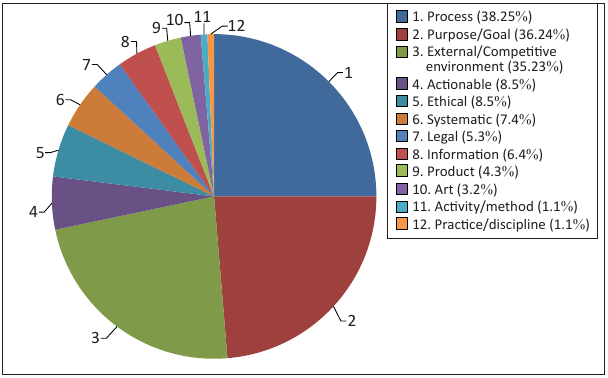
FIGURE 2: Characteristics of competitive intelligence